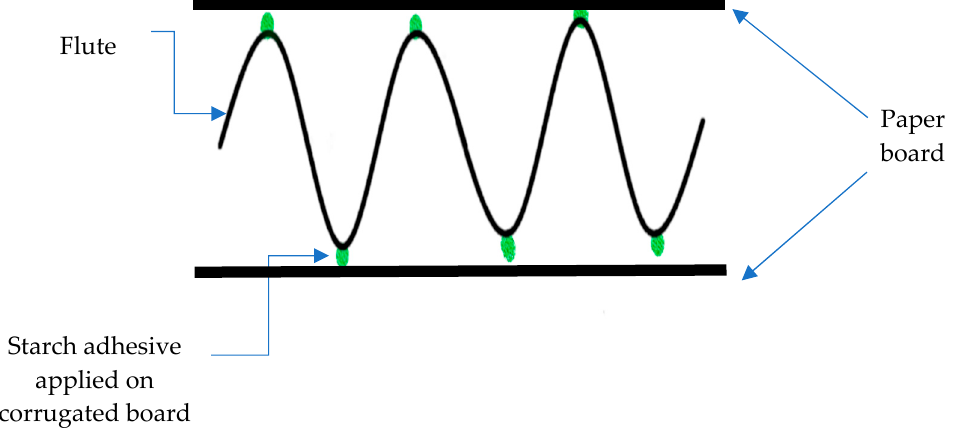
Figure 3. Application of starch adhesive in corrugated cardboard (cross-section view).